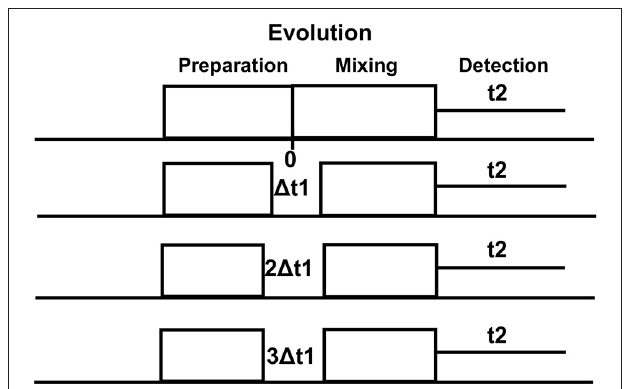
FIGURE 3 | Multiple ( ∼ 64) evolutionary periods ( 1 t1 increments) are collected in a typical 2D-NMR experiment which is a simple series of 1D-NMR experiments acquired with different timings. Higher resolution in t2 (direct dimension) costs little time, but the higher resolution in t1 (indirect dimension) adds directly to the acquisition time of the experiment.